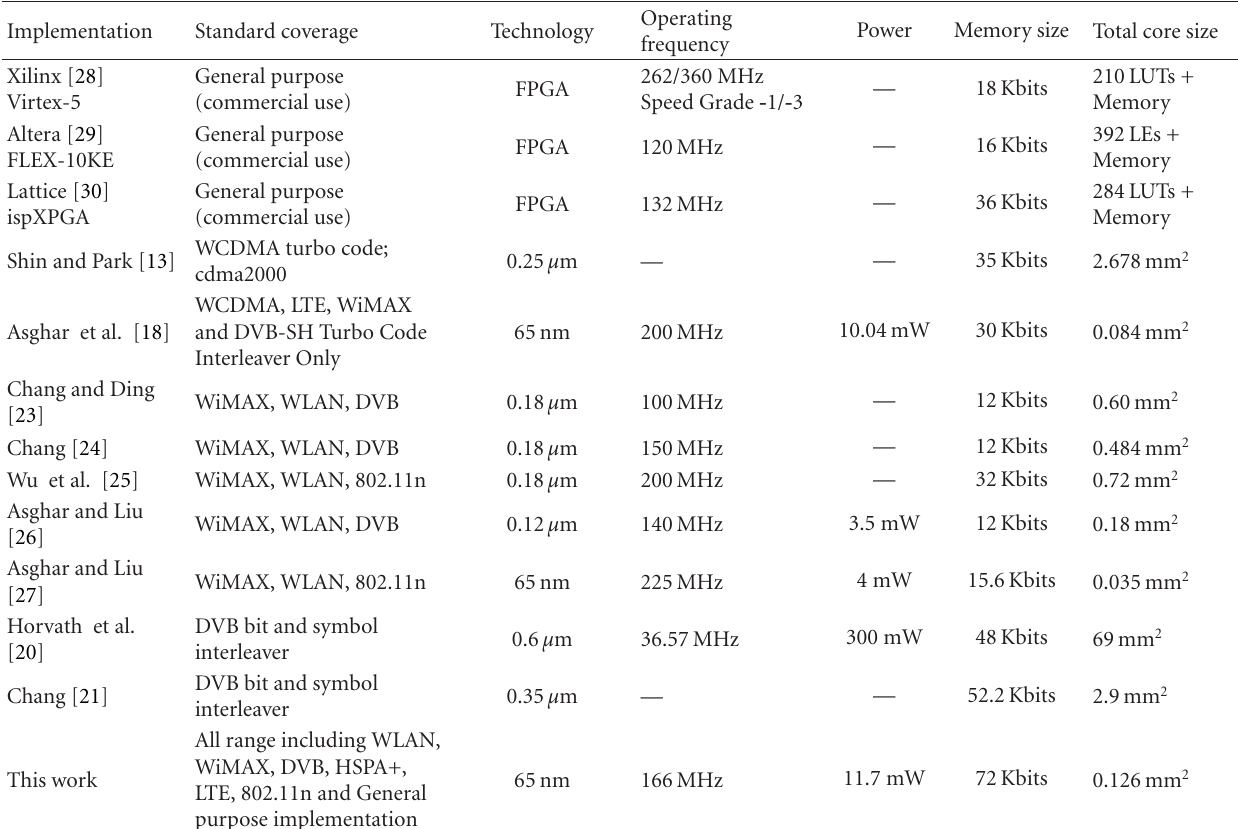
Table 5: HW comparison with other